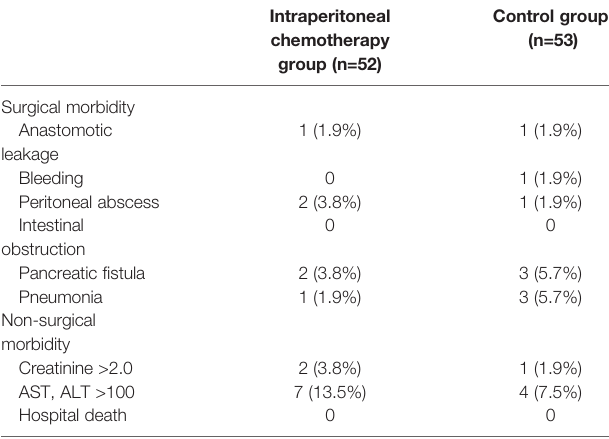
TABLE 5 | Toxic and adverse effects of the patients in the two groups.